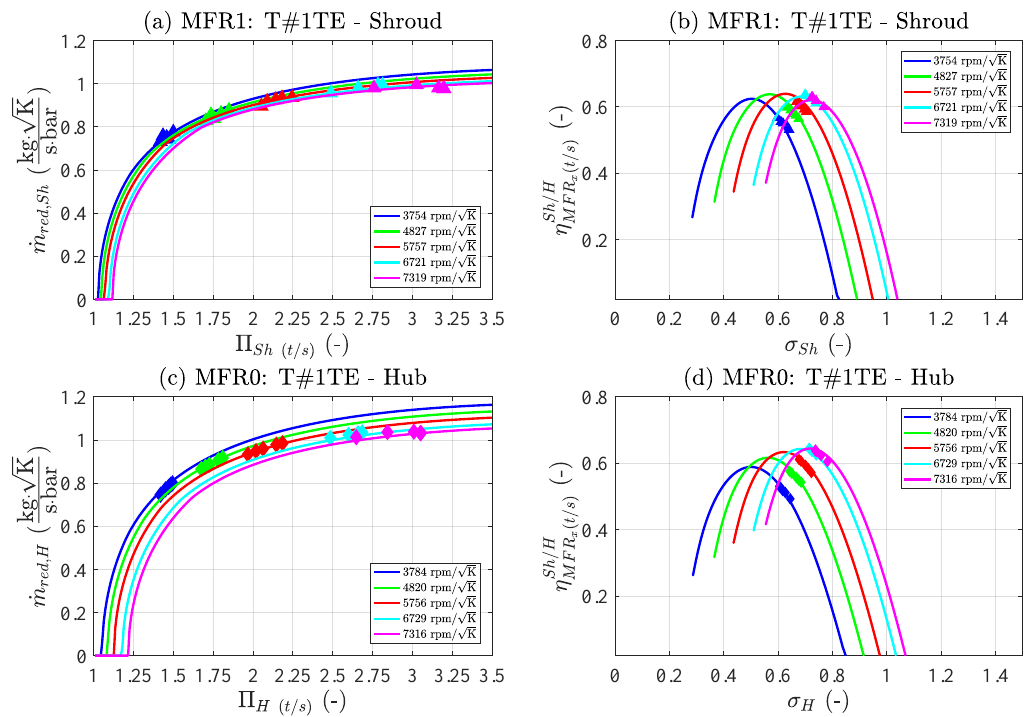
Figure 18. Extrapolation of partial admission conditions for T#1TE ( MFR 0 and